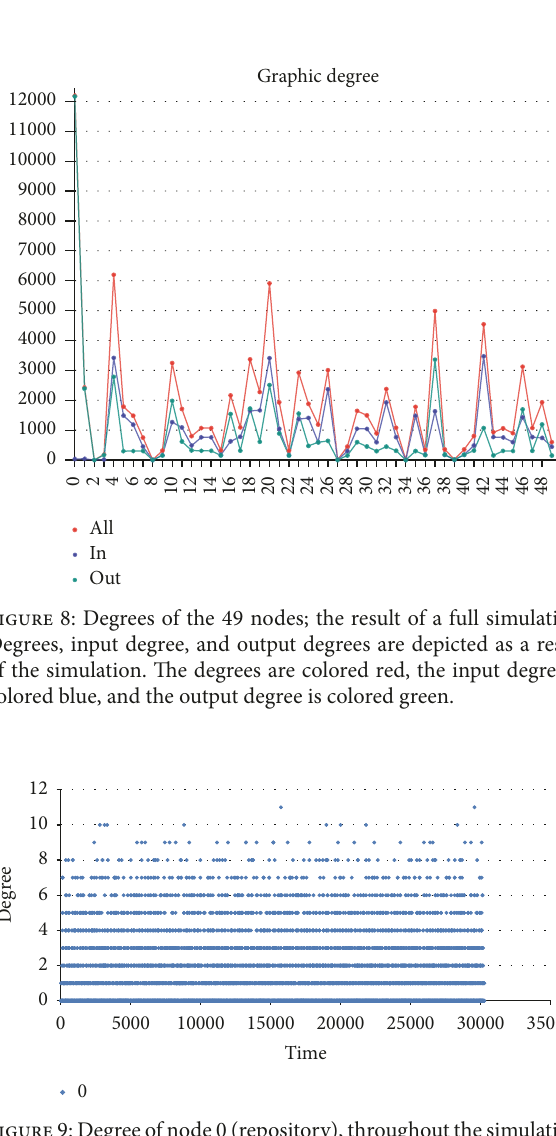
Figure 9: Degree of node 0 (repository), throughout the